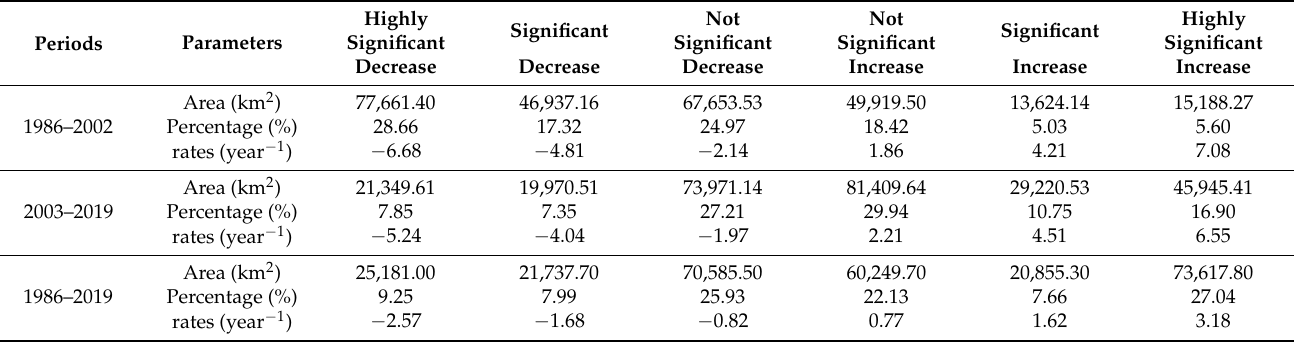
Figure 8. Spatial distribution of the M–K test for the MRSEI in Qaidam Basin from 1986 to 2019. Table 5. Trends and rate of MRSEI change in Qaidam Basin from 1986 to